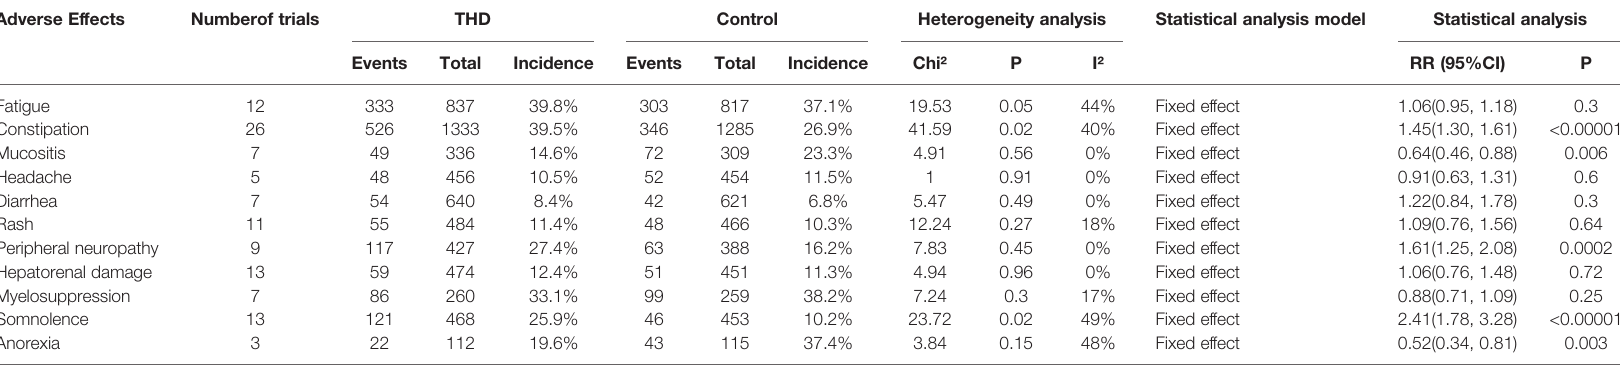
TABLE 2 | Meta-analysis on adverse events.